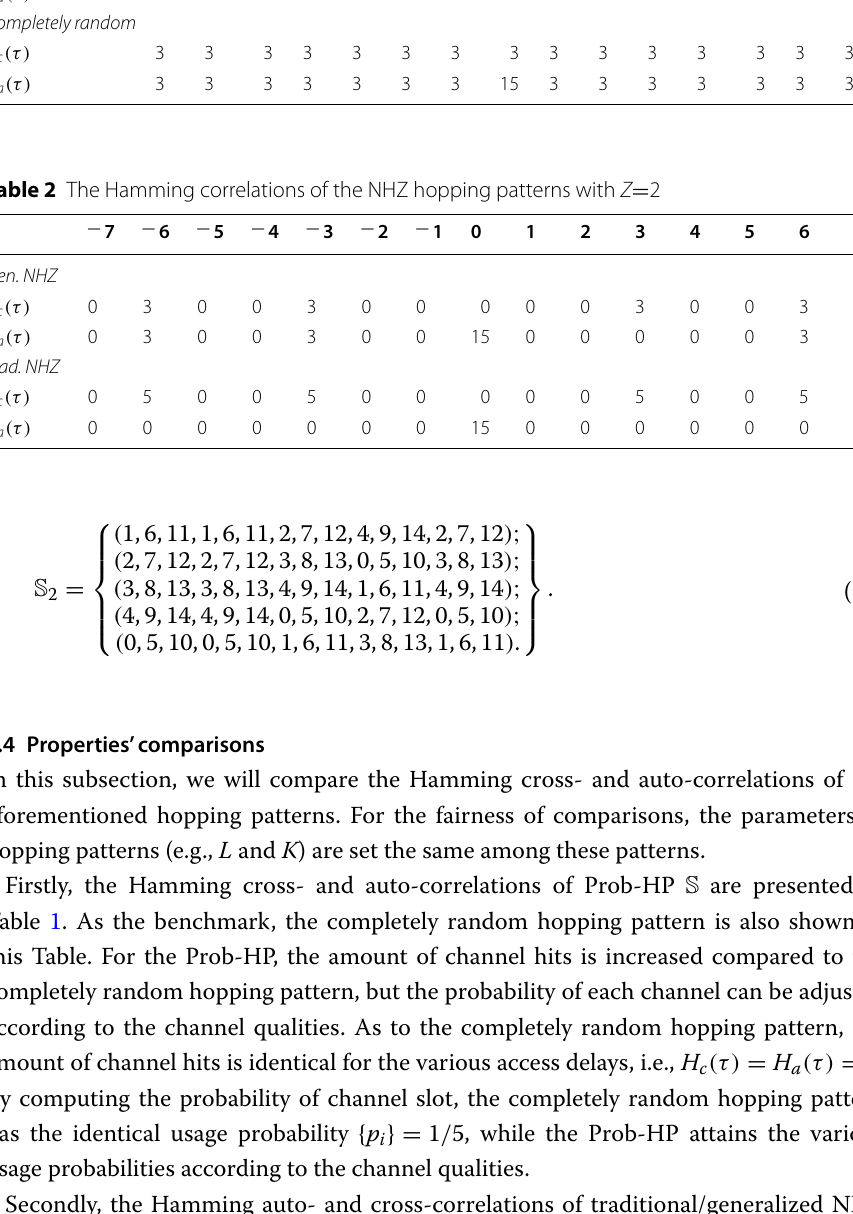
Table 1 The Hamming correlations of the proposed Prob-HP τ